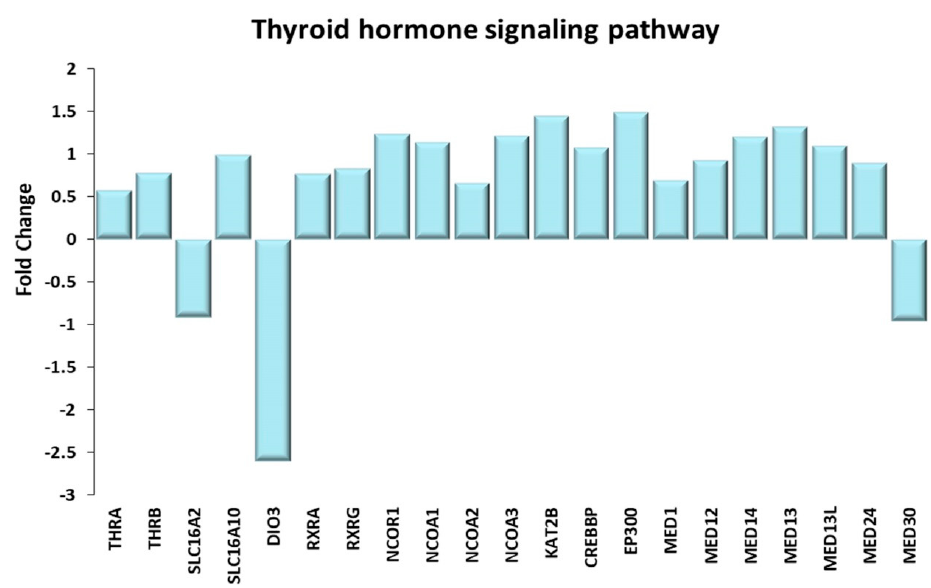
Figure 9. Thyroid hormone signaling pathway. Genes discussed in the text are shown here as fold change in the comparison of TRA and SED subjects. THRA, THRB: thyroid hormone receptor α and β ; SLC16A2: solute carrier family 16 member 2 or MCT8; SLC16A10: solute carrier family 16 member 10 or MCT10; DIO3: iodothyronine deiodinase 3; RXRA, RXRG: retinoid X receptor α , γ ; NCOR1: nuclear receptor corepressor 1; NCOA1, NCOA2, NCOA3: nuclear receptor coactivator 1, 2, 3; KAT2B: lysine acetyltransferase 2B or PCAF; CREBBP: CREB binding protein or CBP; EP300: E1A binding protein p300 or p300; MED1, MED12, MED13, MED13L, MED14, MED24, MED30: mediator complex subunit 1, 12, 13, 13L, 14, 24, 30 or thyroid hormone receptor (TR)-associated proteins (TRAPs).